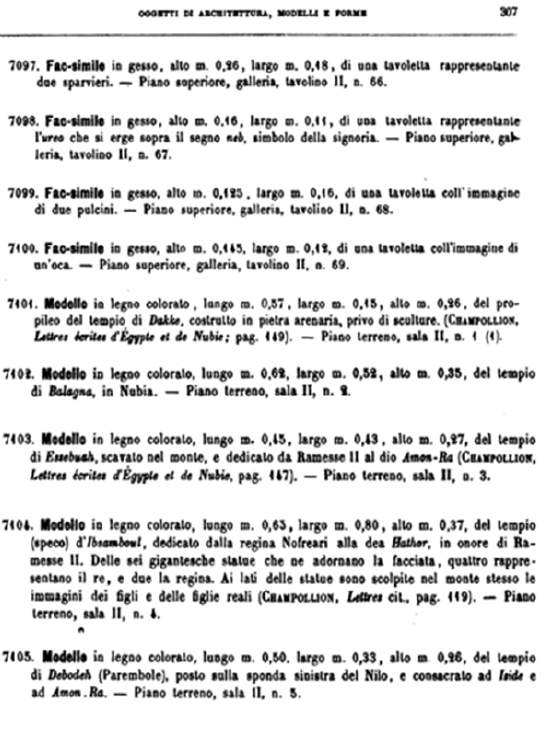
Figure 5. A page from the Fabretti, Rossi, Lanzone